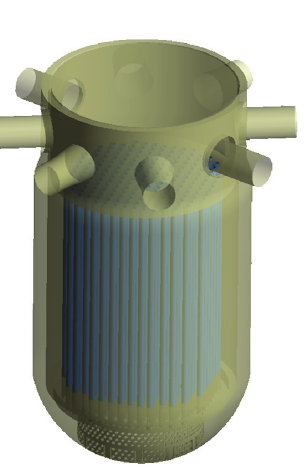
Figure 2: Grid model of ROCOM.